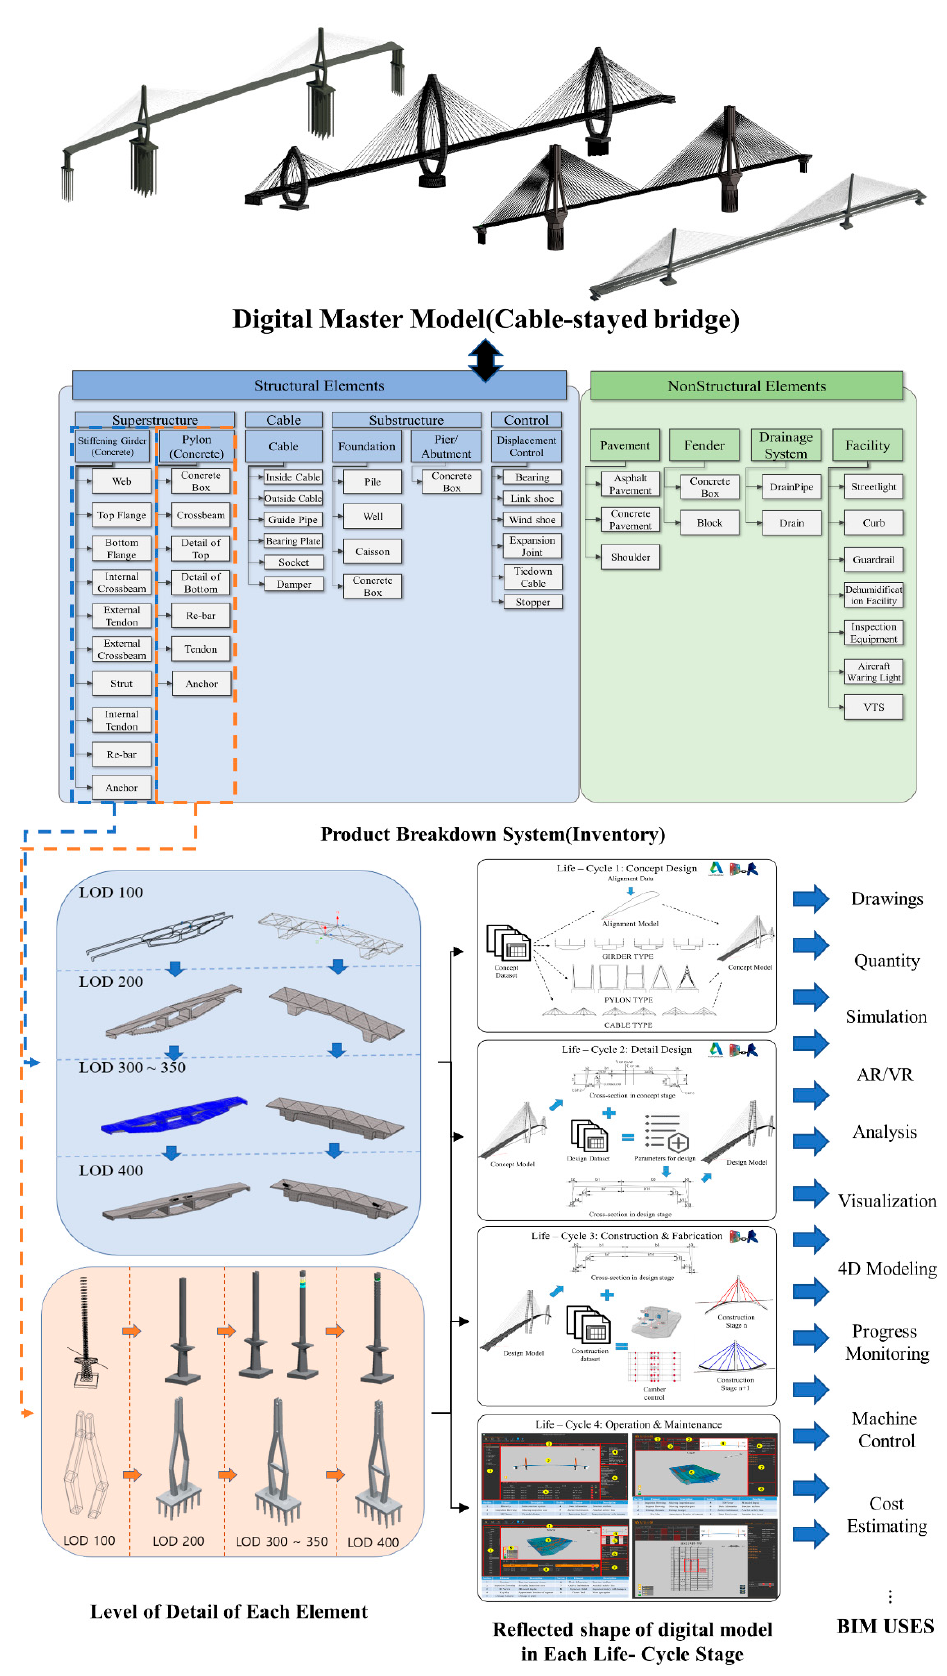
Figure 1. Concept of a master digital model of a cable-stayed bridge. BIM: building information modeling.